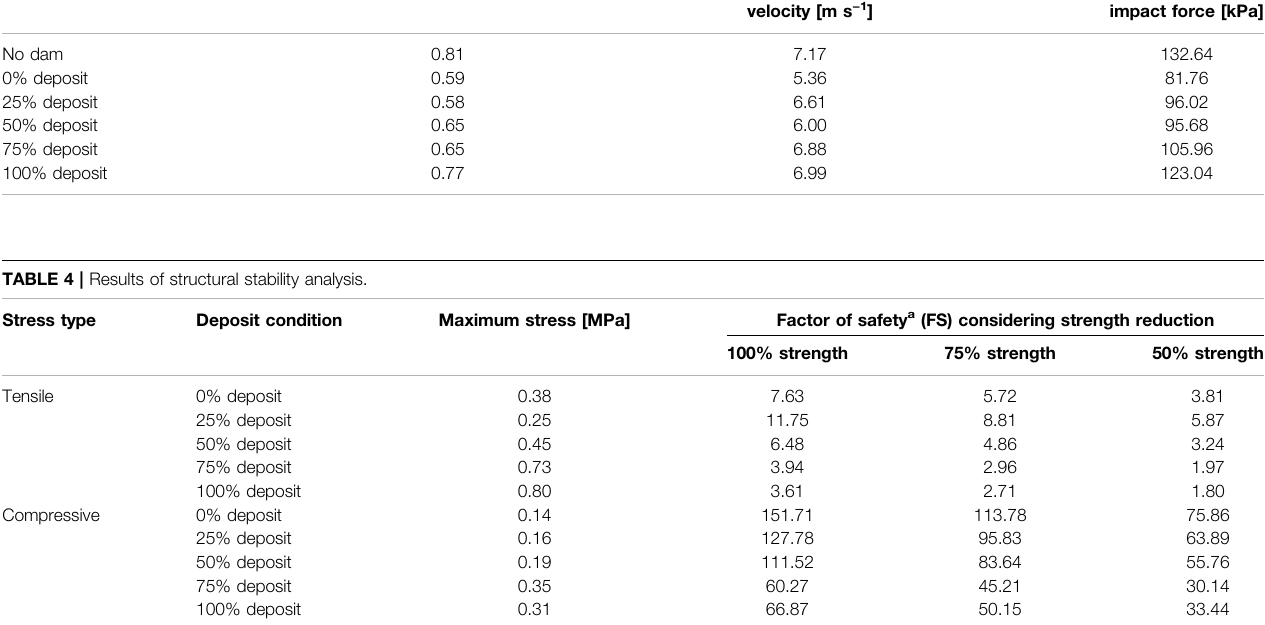
TABLE 3 | Simulation result for debris fl ow characteristics and impact force in each deposit scenario. Deposit condition